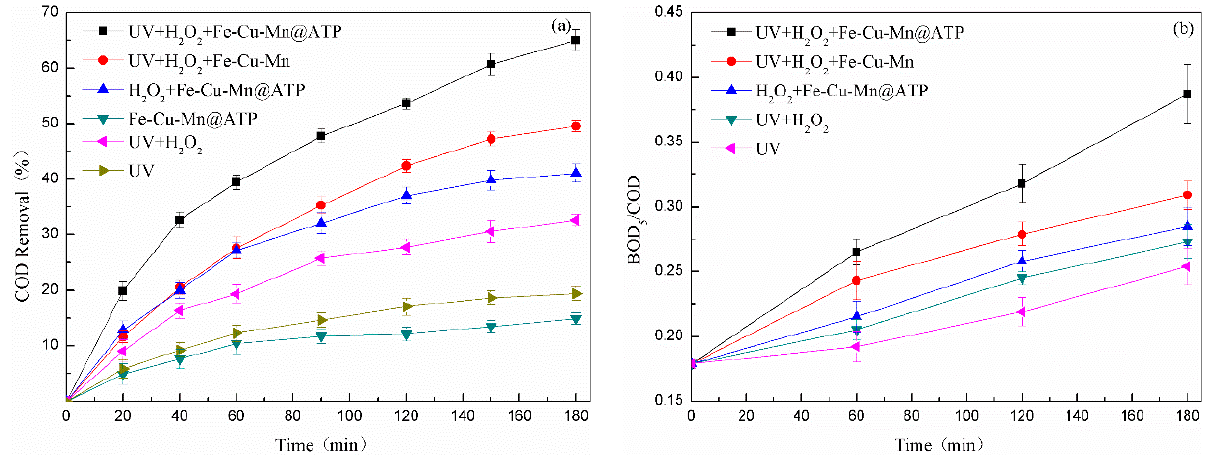
Figure 3. ( a ) COD removal and ( b ) BOD5/COD change of the chemical pharmaceutical wastewater by different treatment systems.